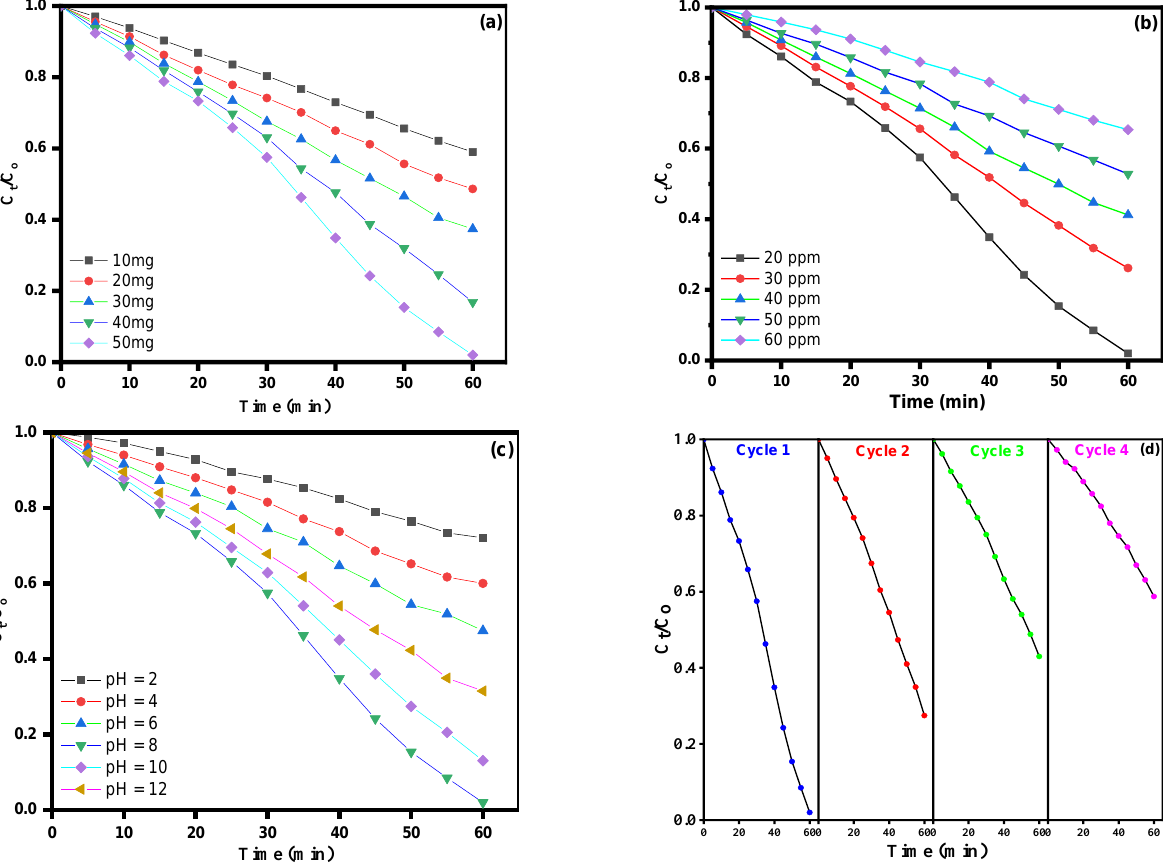
Figure 11. Photodegradation at varying ( a ) catalytic dose (ZnO–Ag nanocomposite), ( b ) varying dye concentrations (MB), ( c ) varying pH values, and ( d ) at various cycles, i.e., from cycle 1 – 4 as per kinetic curve of C t /C o against time (min).